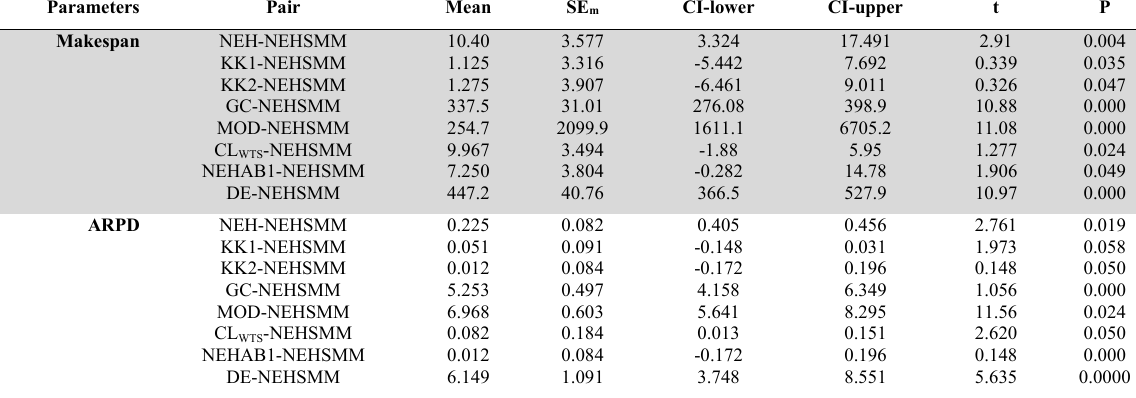
Paired sample t-test result on Taillard's Benchmarks Parameters